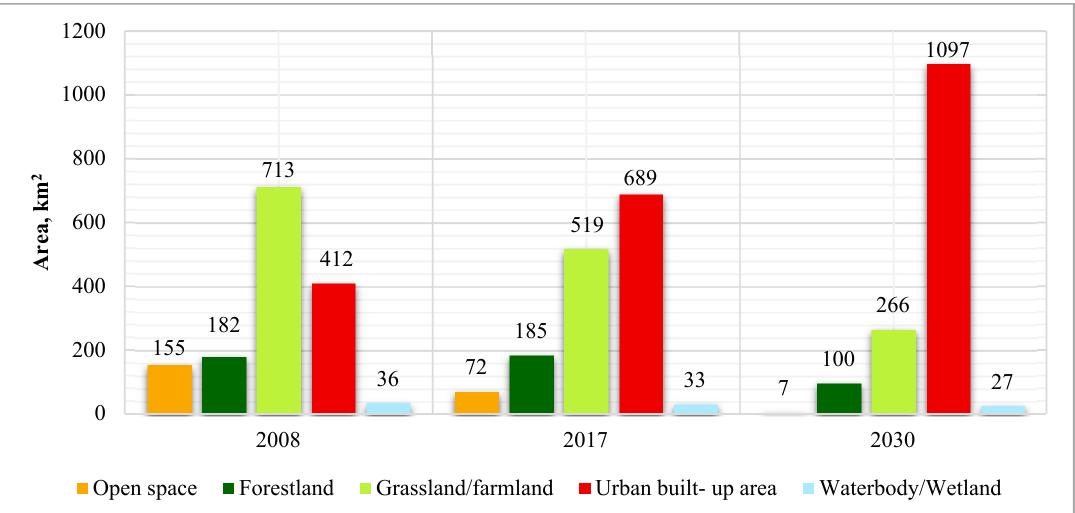
Figure 3. Estimated area of each land-cover class for the years 2008, 2017 and 2030.